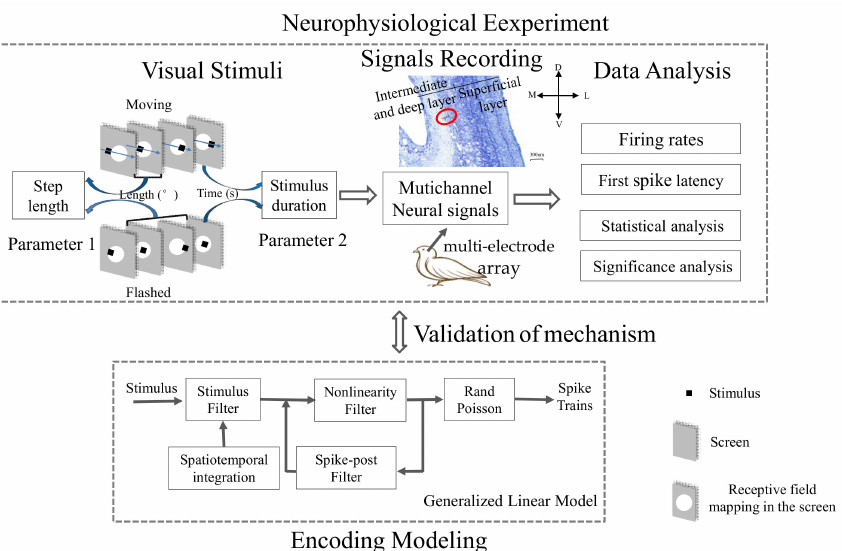
Figure 1. Schematic diagram depicting experimental design and data analysis. The pigeon was firstly restrained and the visual stimuli were presented. Neuronal signals were synchronously collected and the responses to moving and flashed squares were compared. Furthermore, we measured the dependence of response differences on different stimulus parameters. Finally, we adopted the encoding model based on the Generalized Linear Model framework by adding a spatiotemporal integration module, mimicking the spatiotemporal integration of tectal neurons. An example image of brain slices showed the implantation site of a recording